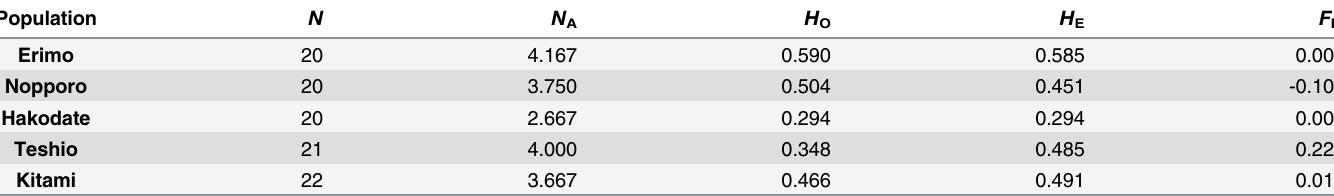
Table 1. Genotypic data of 12 microsatellite loci in populations of the Hokkaido